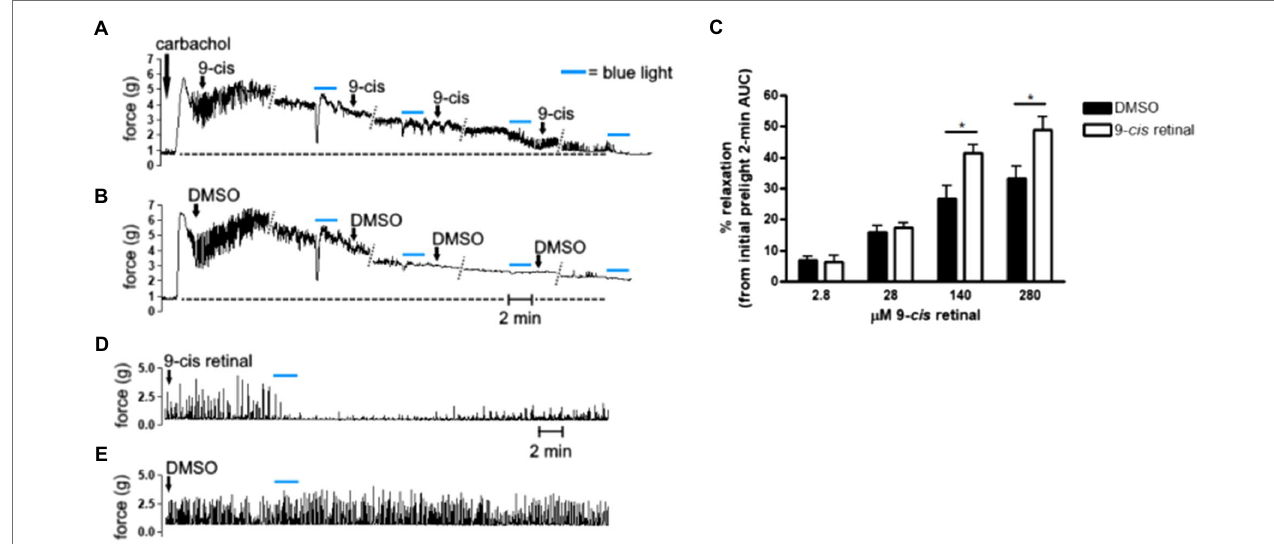
FIGURE 1 | (A,B,D,E) Representative muscle force tracings of ex vivo murine colon rings pretreated with tetrodotoxin (TTX) 1 μ M and contracted with carbachol 100 μ M in wire myography experiments. (A,B) Force tracings of ex vivo colon ring administered increasing final concentrations of (A) 9- cis retinal (9- cis ; 2.8, 28, 140, and 280 μ M), or (B) DMSO vehicle with 15 min in between doses. About 12 min after each dose, rings were exposed to blue light (BL; 435 nm λ ) for 2 min as indicated by the blue bars. Diagonal dotted lines indicate tracing sections cropped for brevity. Dashed line extending perpendicularly from the y-axes approximates baseline, precarbachol tension and demonstrates that 9-cis + BL-treated rings (A) approached baseline tension sooner than DMSO + blue light-treated rings. (C) Area under the curve (AUC) analysis of precontracted ex vivo colon rings administered increasing doses of 9- cis retinal or DMSO vehicle, with intervening blue light treatments. About 2-min AUC during blue light exposures were compared to the 2-min AUC immediately preceding the first light treatment (initial prelight 2-min AUC) to calculate % relaxation. Blue light combined with doses of 9- cis retinal at 140 and 280 μ M produced significantly more relaxation than the corresponding administrations of DMSO and blue light (* p < 0.05, n = 11–26 rings per group). (D,E) Separate ex vivo myography experiments in which precontracted murine colon rings were administered either (D) 280 μ M 9- cis retinal or (E) DMSO vehicle and subsequently exposed to blue light for 2 min. Tracing in (D) demonstrates recovery of carbachol-induced contractions approximately 20–30 min after cessation of blue